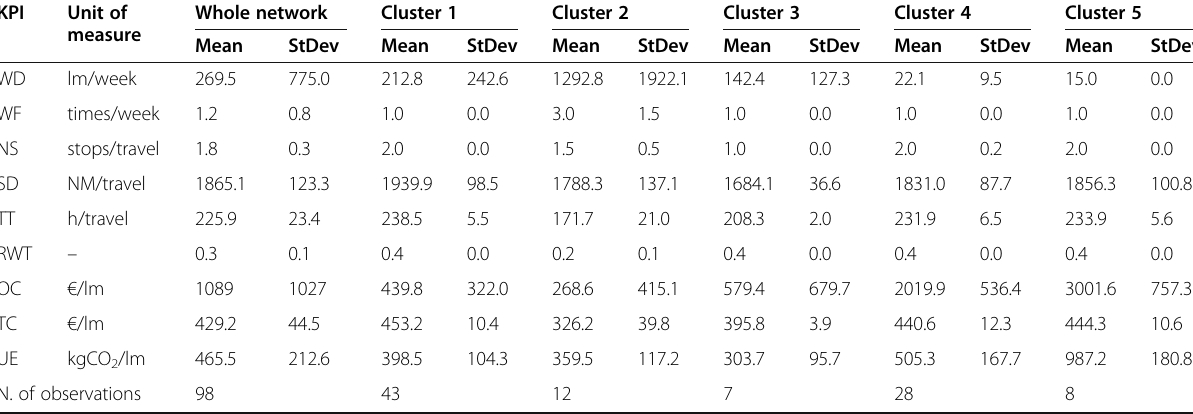
Table 16 Descriptive features of the final partition – Optimized network KPI Unit of